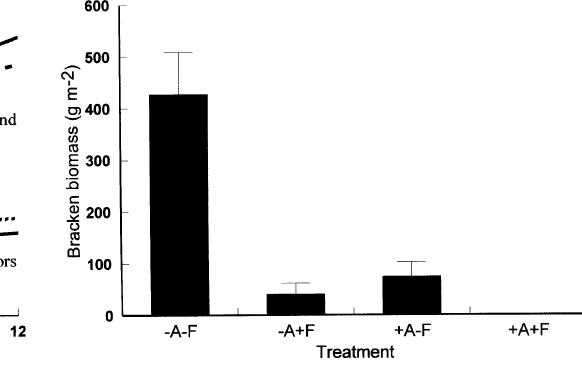
Fig. 1. Changes in site species diversity (N regions of Great Britain. Lines represent best-fit regression equa- tions for clarity.